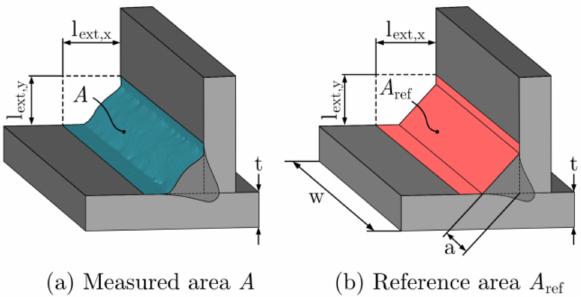
Figure 8. ( a ) Measured area and ( b ) reference area of the welded joint used in the Weakest-link area model.